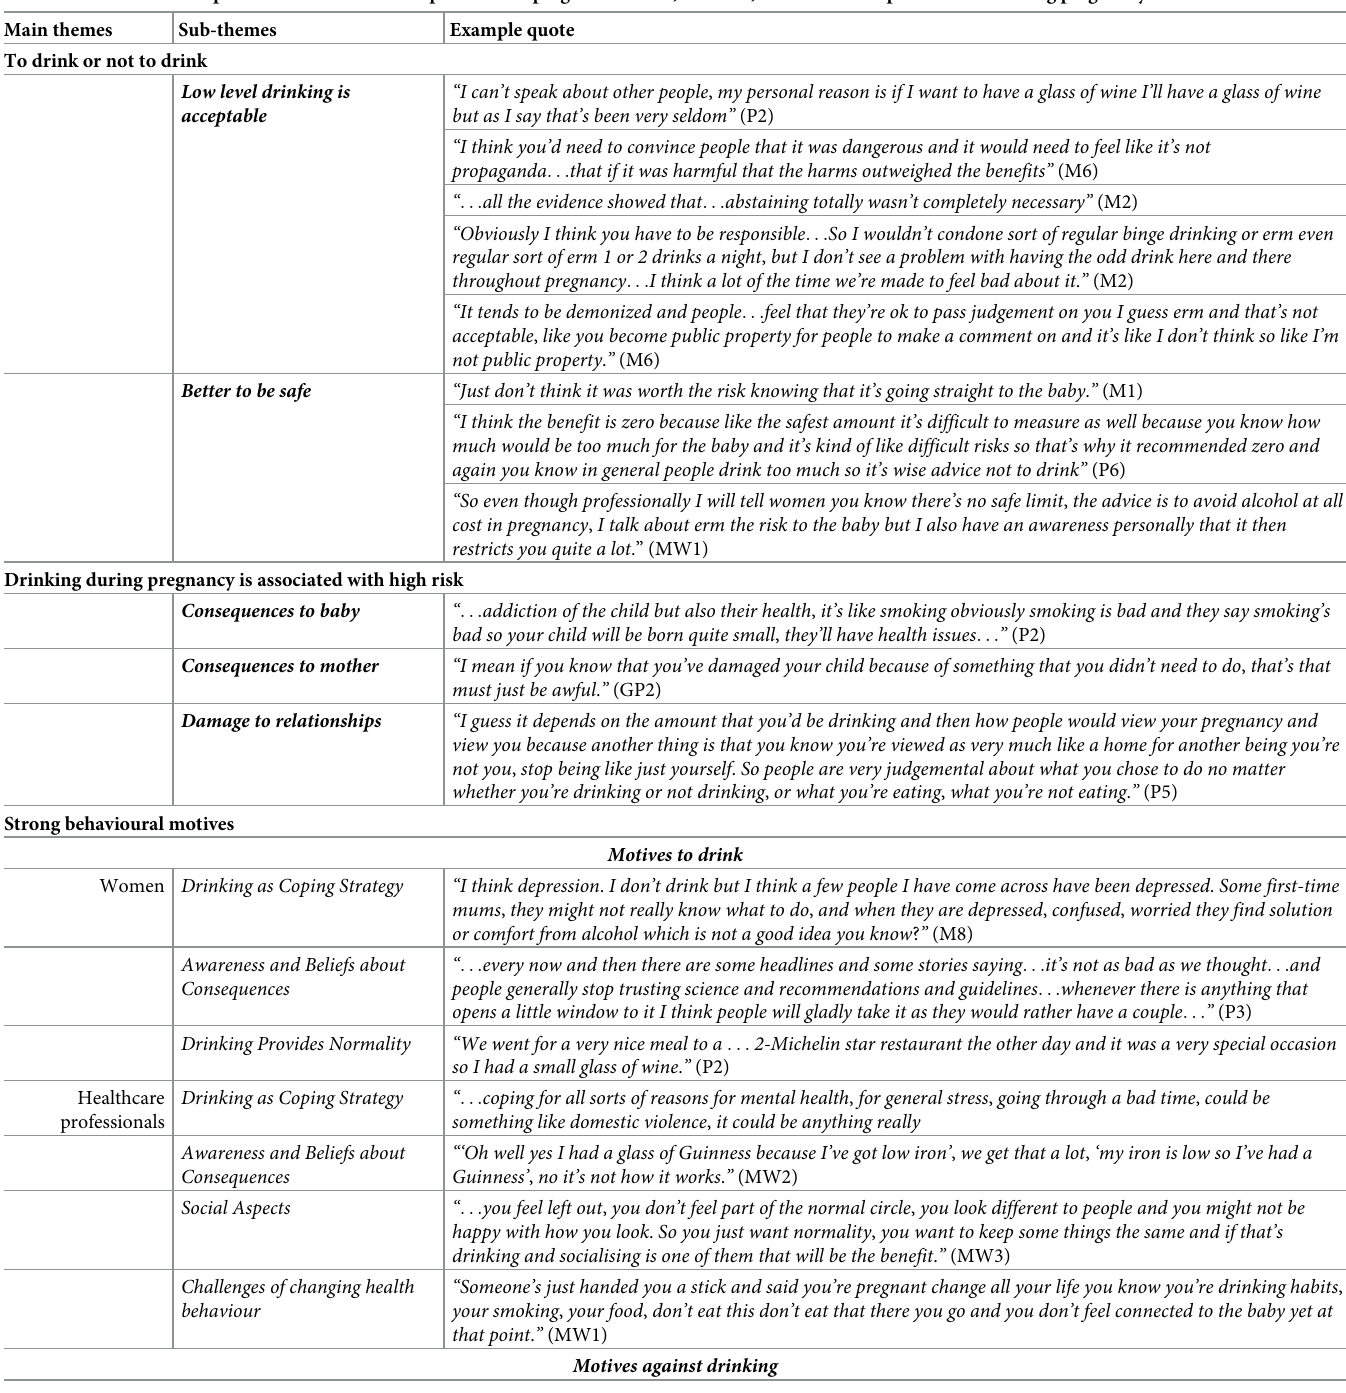
Table 1. Alcohol consumption-related views and experiences of pregnant women, mothers, and healthcare professionals during